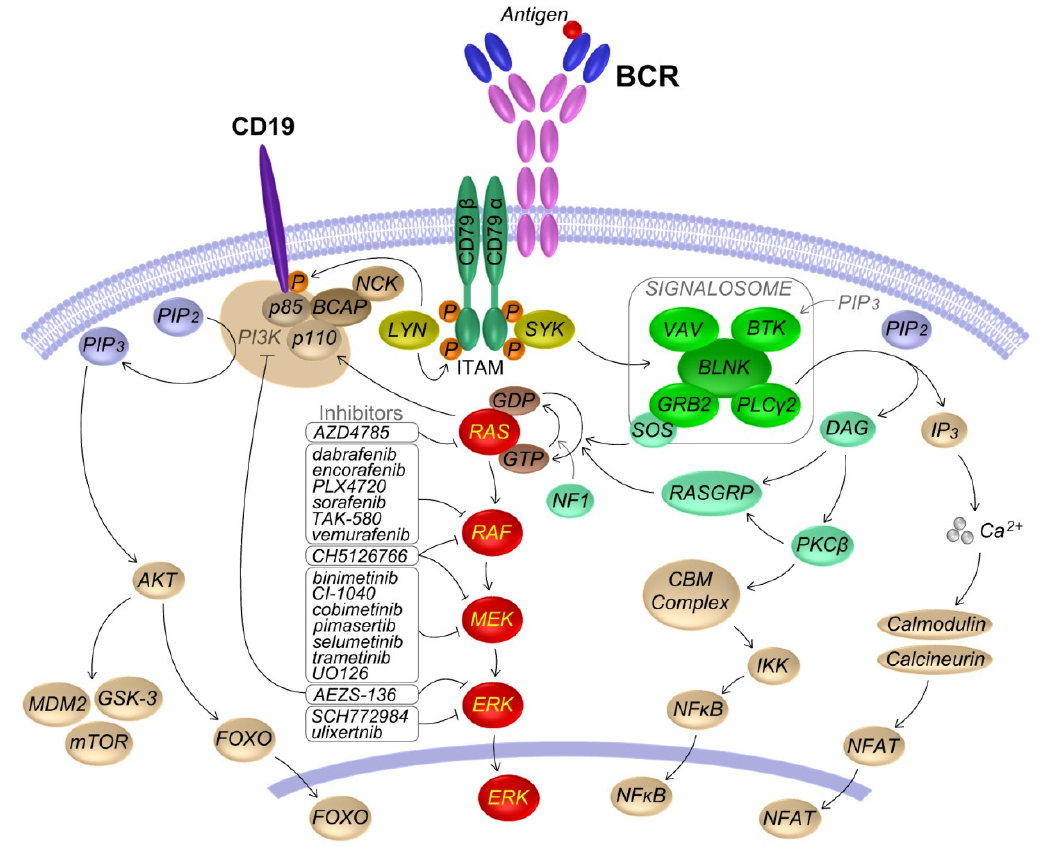
Figure 1. BCR signaling, RAS-MAPK pathway and RAS-MAPK inhibitors. Upon B cell receptor (BCR) antigen binding, LYN (or other SRC kinases) phosphorylates the ITAM domain in the signal transduction subunits CD79A/B. This event promotes the recruitment and activation of spleen tyrosine kinase (SYK), phosphorylation of BLNK and formation of the signalosome. SYK activation of proteins in the signalosome, namely Bruton’s tyrosine kinase (BTK), phospholipase C γ 2 (PLC γ 2), VAV and the growth factor receptor bound protein 2 (GRB2), eventually results in the activation of